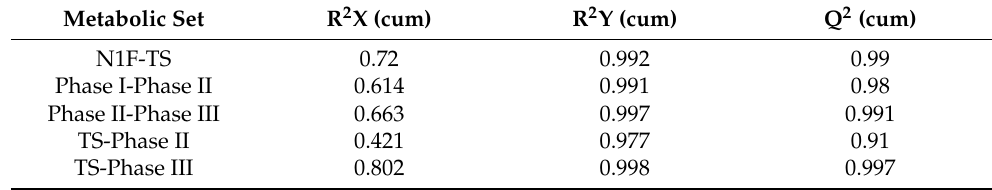
Table 1. Parameters of differential metabolites based on